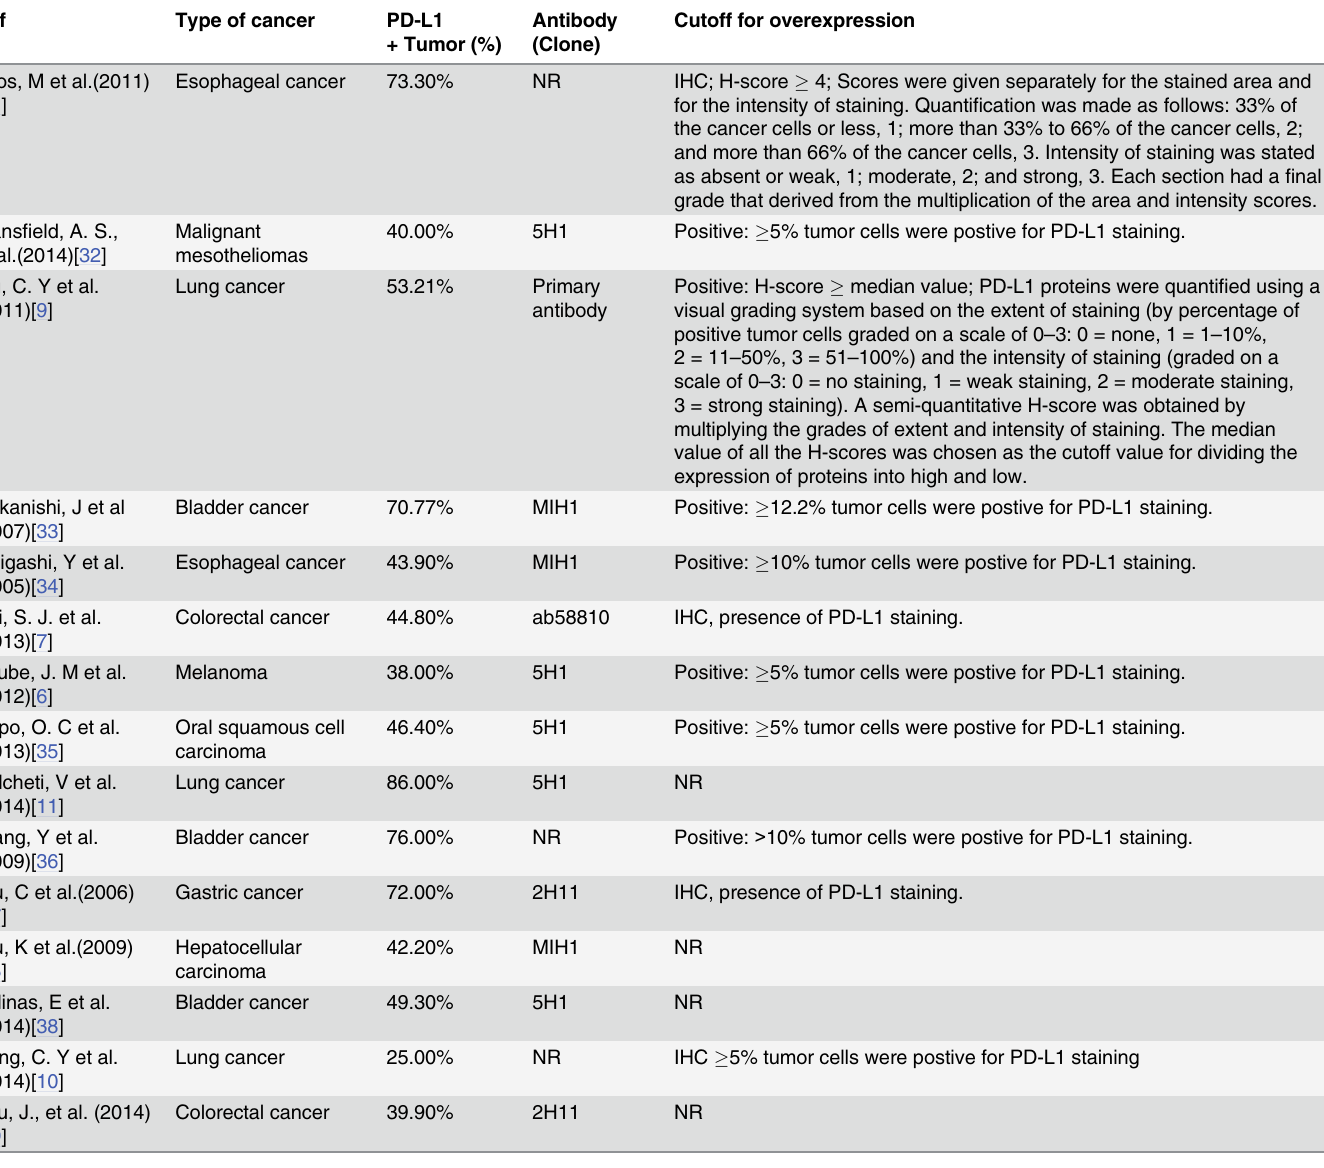
PD-L1 overexpression depended on the staining score and the method used. Among the group determined as PD-L1 overexpressed, the median overexpression of PD-L1 staining was 45.4%. Esophageal cancer, gastric cancer, and oropharyngeal squamous cell carcinoma had the highest expression of PD-L1, with more than 66.7% of tumors considered overexpression. Levels of PD-L1 overexpression in urothelial cancer, pancreatic carcinoma, colorectal cancer, mela- noma, lung cancer, hepatocellular carcinoma, esophageal cancer, glioblastoma and cervical car- cinoma ranged from 19% to 54.3%.